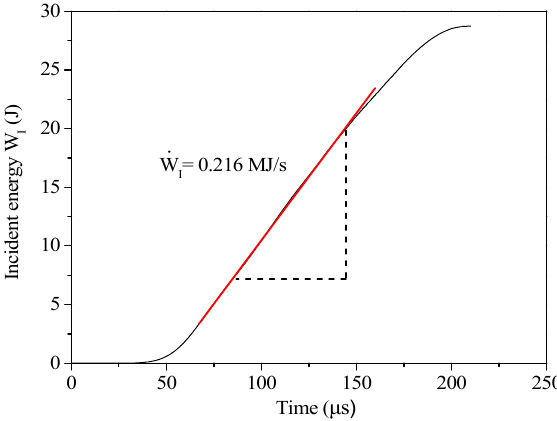
Figure 12. Calculated method of the average change rate of the incident energy.